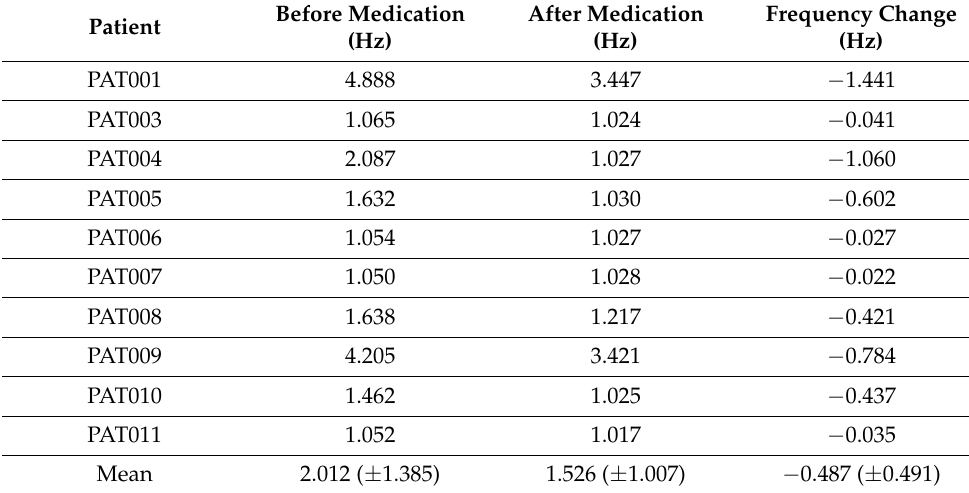
Table 5. Estimated dominant frequencies.